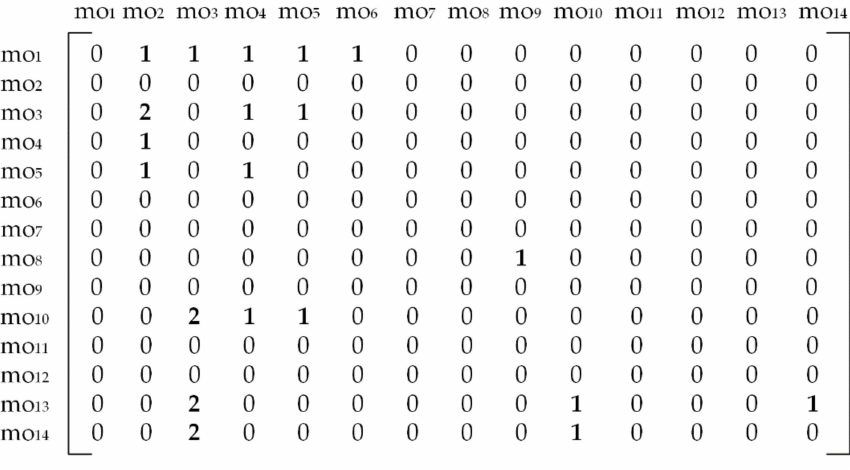
Figure 10. The adjacency matrix for prismatic part